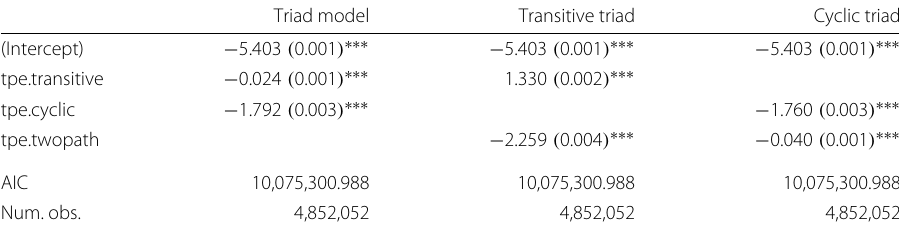
Table 11 Explaining third-party edit events by past third-party edits on transitive and cyclic two-paths Triad model Transitive triad Cyclic triad (Intercept) − 5.403 ( 0.001 ) ∗∗∗ − 5.403 ( 0.001 ) ∗∗∗ − 5.403 ( 0.001 ) ∗∗∗ tpe.transitive − 0.024 ( 0.001 ) ∗∗∗ 1.330 ( 0.002 ) ∗∗∗ tpe.cyclic − 1.792 ( 0.003 ) ∗∗∗ − 1.760 ( 0.003 ) ∗∗∗ tpe.twopath − 2.259 ( 0.004 ) ∗∗∗ − 0.040 ( 0.001 ) ∗∗∗ AIC 10,075,300.988 10,075,300.988 10,075,300.988 Num. obs.